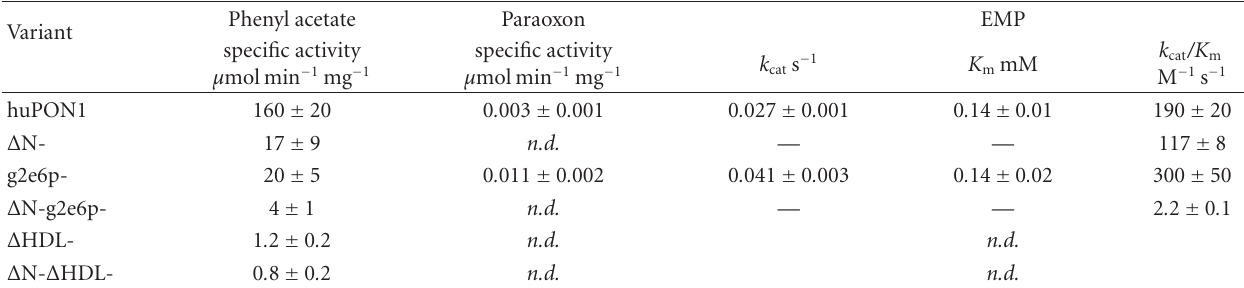
Table 1: Aryl esterase and OPase activity of huPON1 variants. Phenyl acetate and paraoxon specific activities were determined at 3.3 mM and 2.6 mM substrate, respectively. Errors for the specific activities are the standard errors from 3 trials. EMP values were determined at constant 2% methanol, and the errors are with respect to the fit. n.d. : not detected. —: k cat / K m is reported from a linear fit of initial rate versus substrate concentration when the enzyme could not be saturated under experimental conditions.